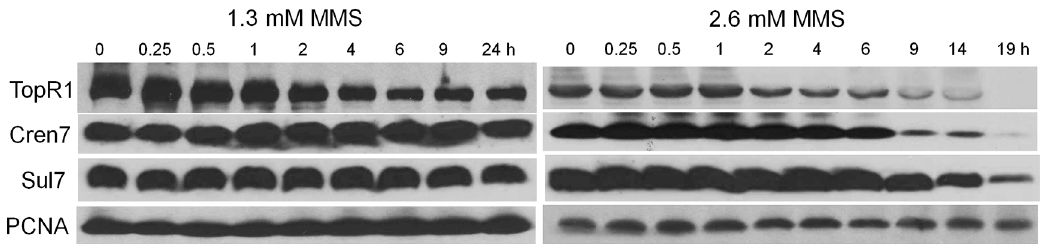
Figure 4. Western blot analysis of the levels of TopR1, Cren7, Sul7, and PCNA3 in the cells treated with 1.3 and 2.6 mM MMS. The sampling time points during the treatments are indicated. Total protein of about 1.3 × 10 8 cells, given that a culture of OD 600 = 1.0 contains 1 × 10 9 cells per mL, was loaded onto the gel.